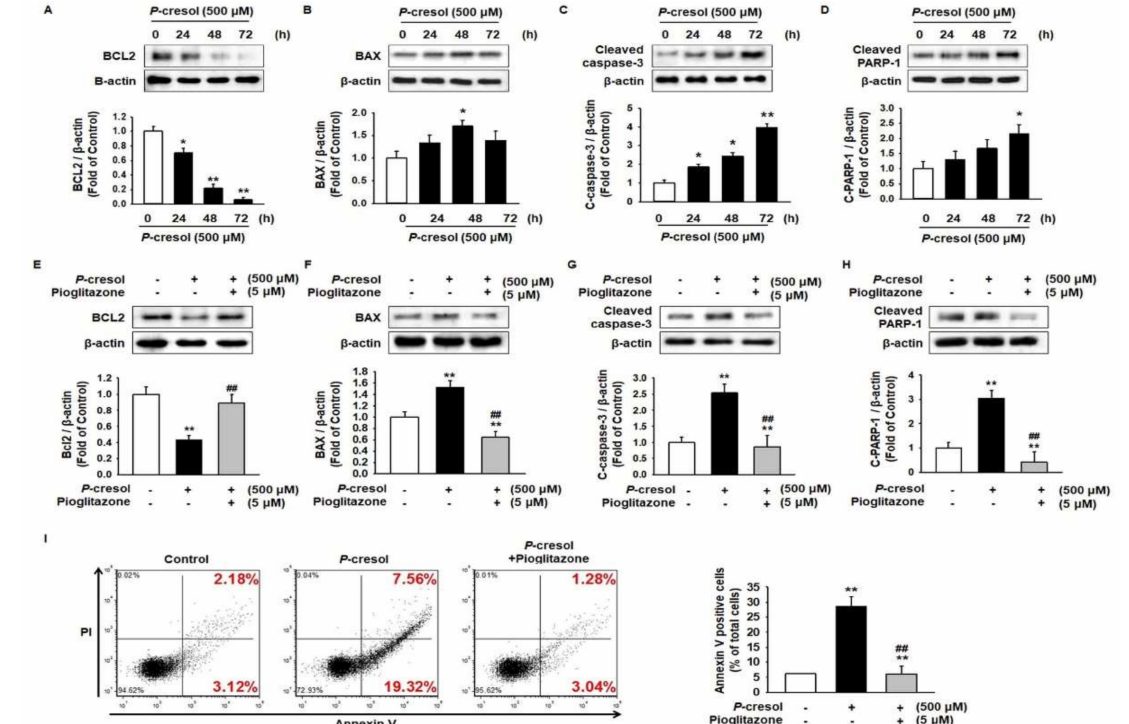
Figure 1. Pioglitazone-treated mesenchymal stem cells (MSCs) and induced apoptosis on exposure to P -cresol (PC). ( A – D ) Western blot was used to analyze the expression of apoptosis-associated proteins BCL2, BAX, cleaved caspase-3, and cleaved PARP-1 in MSCs exposed to PC (500 µ M) for 0, 24, 48, and 72 h. The expression levels were determined by densitometry relative to β -actin. Values represent the mean ± standard error of the mean (SEM). * p < 0.05, and ** p < 0.01 vs. untreated MSCs. ( E – H ) Western blot was used to analyze MSCs pretreated with pioglitazone (5 µ M; 24 h) for the expression of apoptosis-associated proteins BCL2, BAX, cleaved caspase-3, and cleaved PARP-1 on exposure to PC. The expression levels were determined by densitometry relative to β -actin. Values represent the mean ± SEM. ** p < 0.01 vs. untreated MSCs, ## p < 0.01 vs. MSCs exposed to PC. ( I ) Annexin V and PI positive cells were detected using fluorescence-activated cell sorting (FACS) analysis. Values represent the mean ± SEM. ** p < 0.01 vs. untreated MSCs, ## p < 0.01 vs. MSCs exposed to